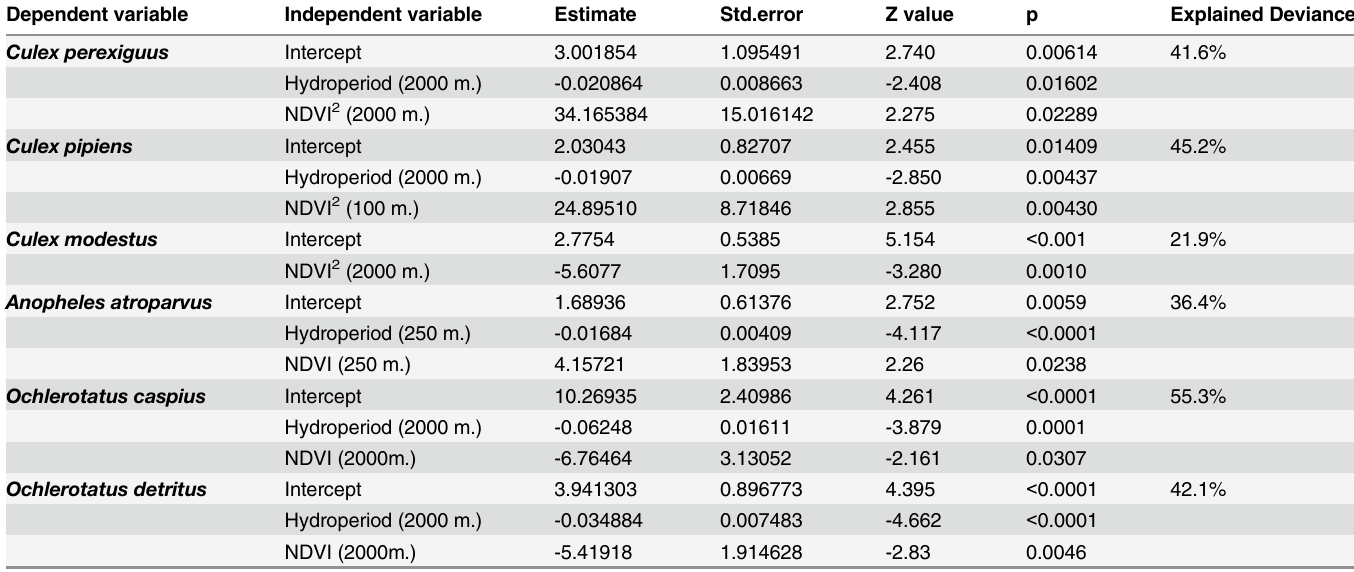
Table 2. Results of the Generalized Linear Model (binomial) of annual presence for six mosquito species ( Cx . theileri is not analysed) vs hydroper- iod and NDVI estimated at five buffers of different size. NDVI 2 is the quadratic effect of NDVI. Dependent